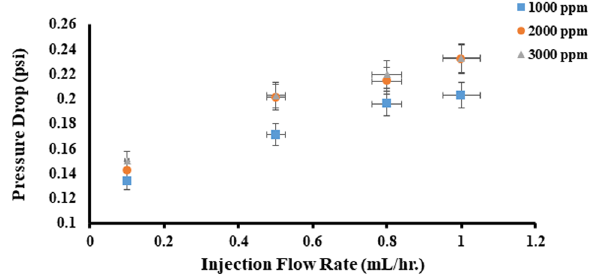
Fig. 5 Pressure drops versus injection flow rates for a simple fracture micromodel at different PPG concentrations including 1000, 2000, and 30,000 ppm at T = 25 °C and P = 0.846